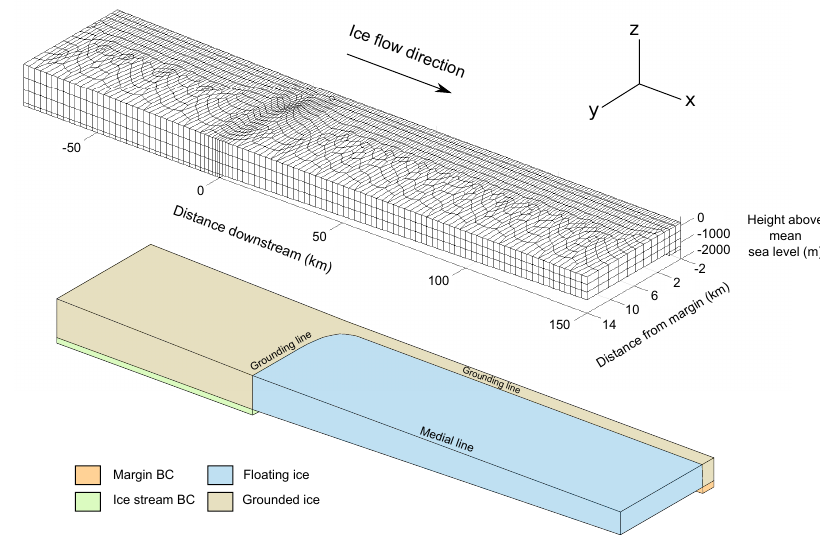
Figure 3. Finite-element mesh used in the full-Stokes viscoelastic model (Sect. 4). Note that x and y horizontal scales have been reduced by a factor of 10 and 2,